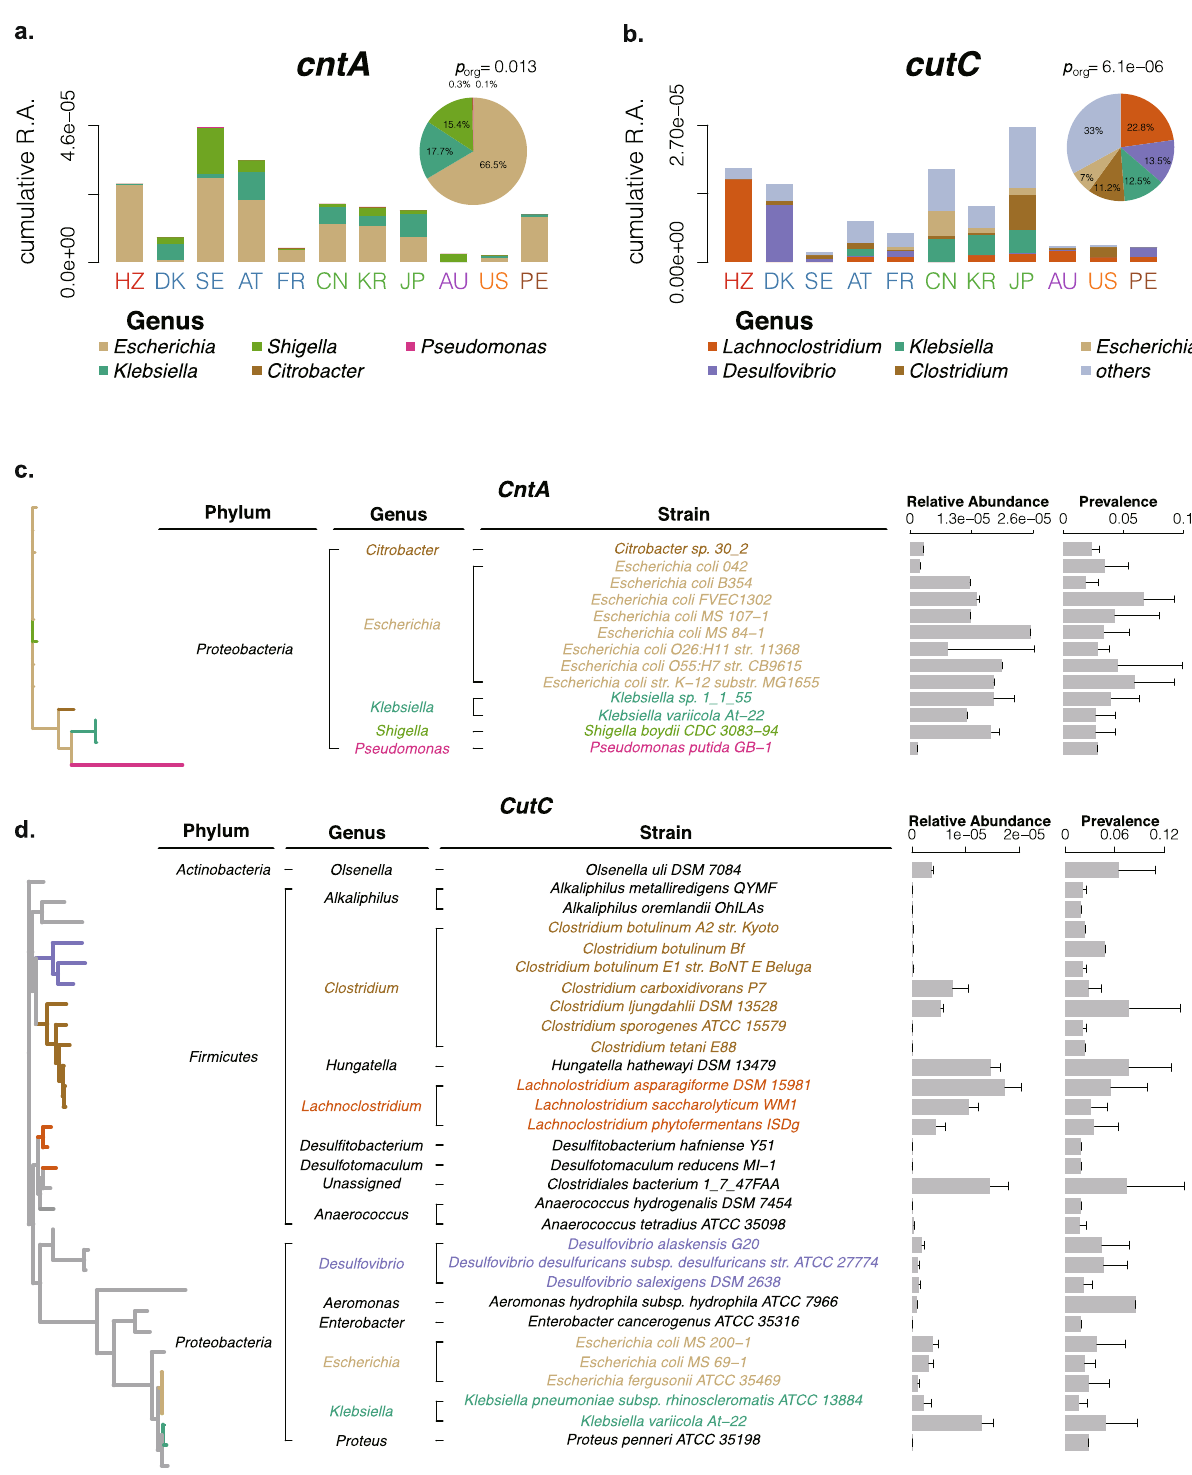
Fig. 2 R.A. distribution and taxonomic identi fi cation of cntA and cutC . R.A. distribution of cntA ( a ) and cutC ( b ) in 11 populations from six continents. Stack columns display the cumulative R.A. of different genera and pie charts in the corner show the distribution of the abundant genera. The detailed 11 populations from six continents include: Africa: HZ (the Hadza ethnic group of Tanzania); Asia: CN (China), JP (Japan), and KR (South Korea); Europe: DK (Denmark), SE (Sweden), AT (Austria), and FR (France); Oceania: AU (Australia); North America US (the United States); South America: PE (Peru). Signi fi cant differences in R.A. were conducted by Kruskal – Wallis rank sum test p org . Taxonomic identi fi cation of cntA ( c ) and cutC ( d ). The left panels show the phylogenetic tree and the highlighted branches correspond to the colors of different genera on the middle panel. The bar charts on the right panel indicate the average R.A. and the prevalence of cntA and cutC among different intestinal strains. R.A.: relative abundance. Error bars denote the means ±